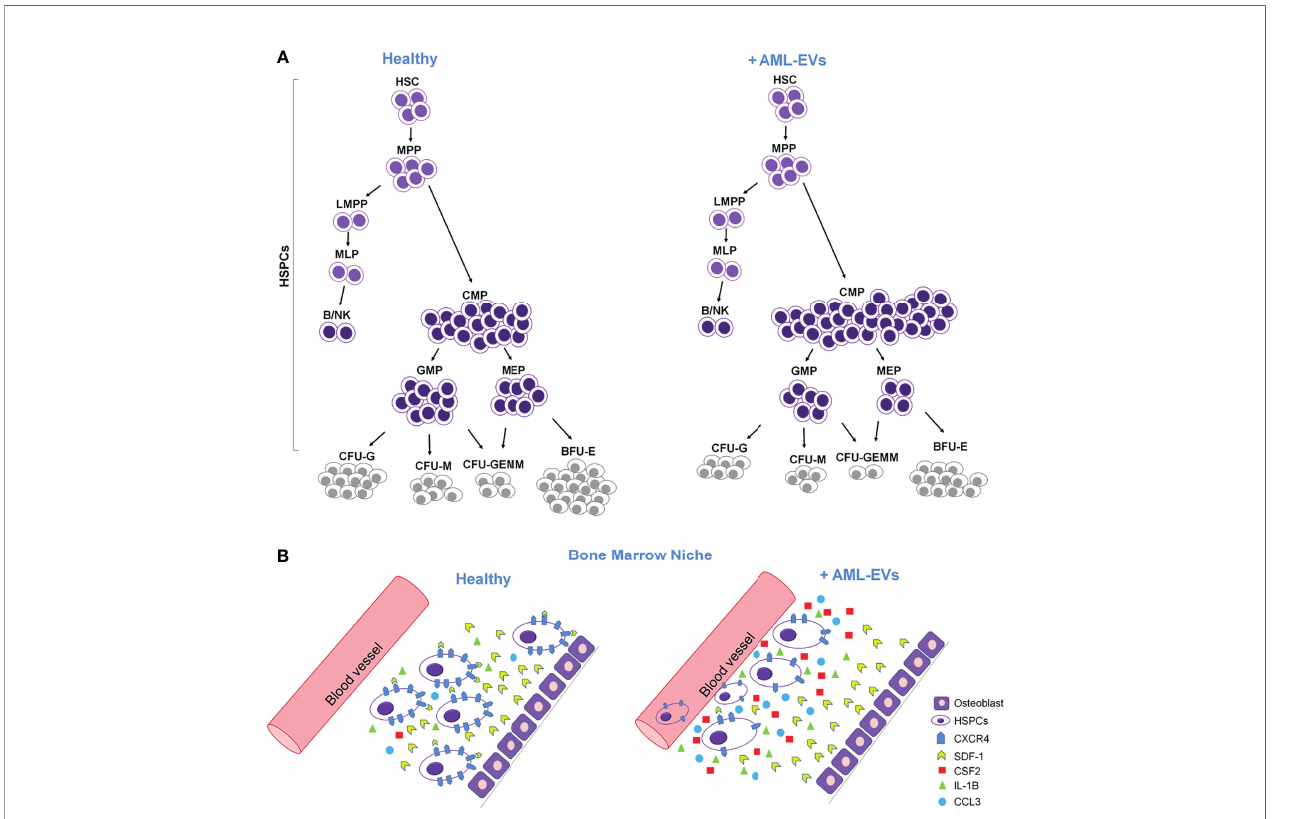
FIGURE 8 | Cartoon describing the effects of AML-EVs on HSPCs. (A) AML-EVs inhibit the differentiation of HSPCs inducing: (1) an increase of common myeloid progenitors (CMP), (2) a decrease of granulocyte macrophage progenitors (GMP) and megakaryocyte erythroid progenitors (MEP), and (3) a decrease of myeloid colonies [Burst-Forming-Unit Erythrocyte (BFU-E), colony forming unit (CFU)- Granulocyte, Erythrocyte, Macrophage, Megakaryocyte (CFU-GEMM), CFU Granulocyte (CFU-G) and CFU Macrophage (CFU-M)]. (B) Schematic model of both healthy and leukemic BM niche. AML-EVs induce an increase of in fl ammatory cytokines such as CCL3, CSF2 and IL-1B, and a decreased expression of CXCR4 accompanied by a reduced SDF-1 mediated attraction of